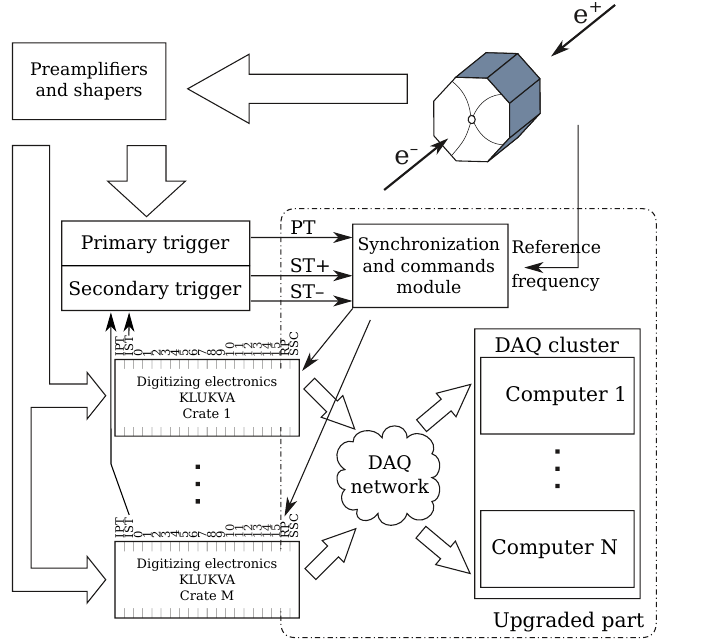
Figure 2. Main components of the KEDR DAQ system, with IPT — interface to the primary trigger, IST — interface to the secondary trigger, RP — readout processor, SSC — service signal coupler (signals distributor), 0–15 — information